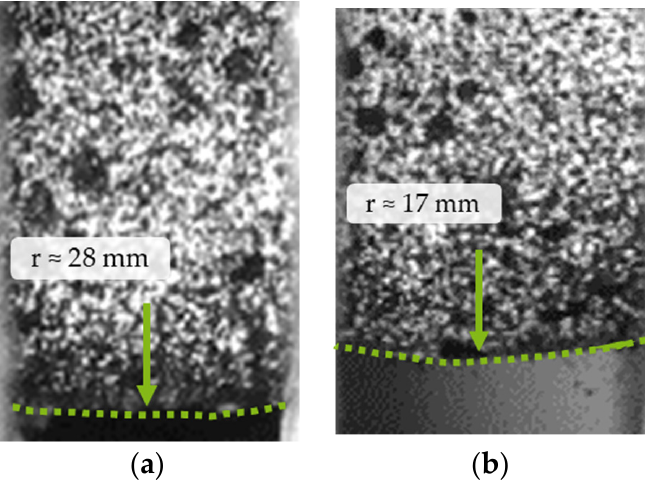
Figure 12. Bulge of ( a ) AISI 1045 steel and ( b ) the Ti6Al4V alloy in SHPB tests.